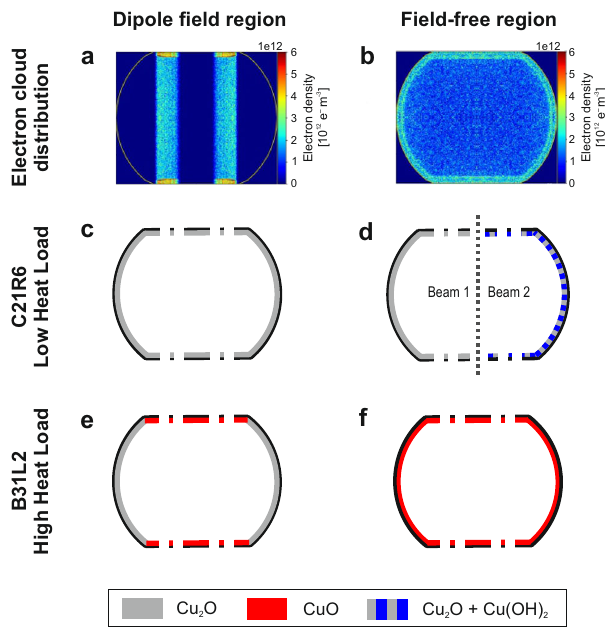
Fig. 9 Summary of copper oxidation state. a , b Summary of the electron cloud density distributions obtained from simulations; schematic of the distribution of the different main copper oxidation products found on the beam screens of c , d the Low and e , f the High Heat Load LHC dipoles and their dependence on the magnetic fi